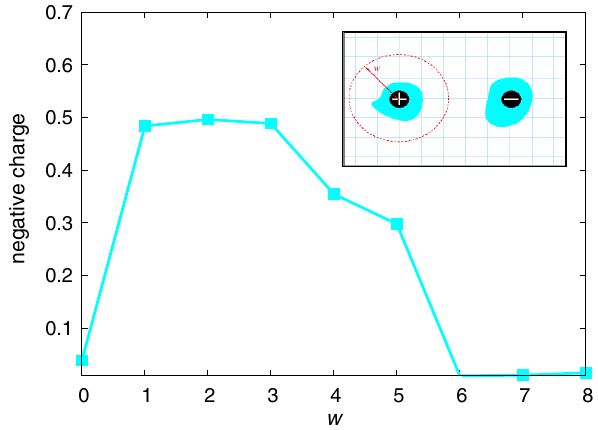
FIG. 8. Measurement of the Witten effect. The inset shows the measurement setup. External monopoles are inserted into the system, at a distance L= 2 apart. They carry hedgehog numbers of (cid:3) 1 = 2 , and are Debye screened by hedgehogs of equal and opposite number, which also carry half of a boson charge. The main plot shows the boson charge enclosed in a sphere of radius w . For w ≈ 1 – 3 , this sphere measures the boson charge in the screening cloud near the origin, and the result is 1 = 2 , as expected. For w ≳ 5 , the sphere includes the charge from the other screening cloud, and the enclosed charge drops to zero. The system size is L ¼ 10 , using bulk parameters β ¼ 0 . 2 , K ¼ 0 . 4 , λ ¼ 8 (cf. bottom panel in Fig. 7), and local biasing parameter γ ¼ 1 . 5